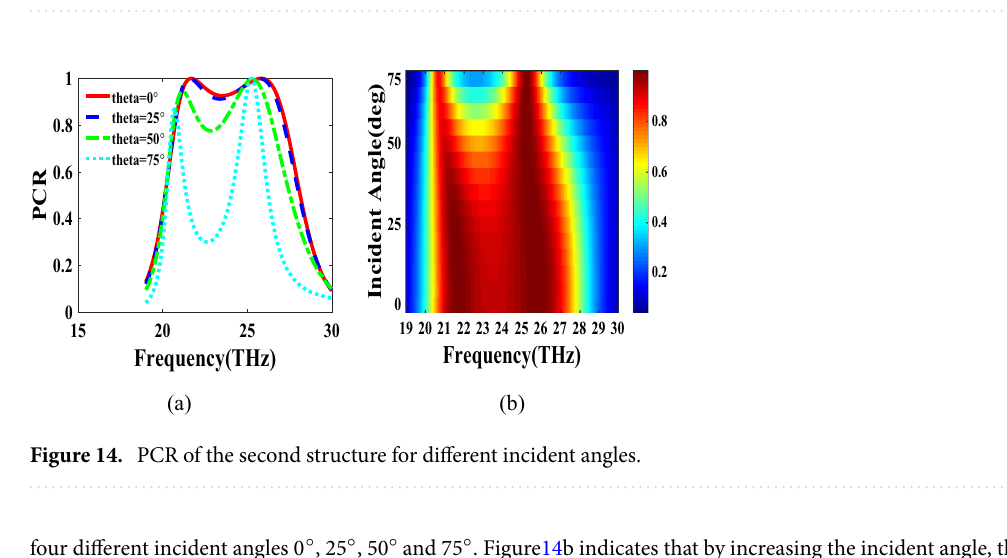
Figure 13. PCR of the second structure for different chemical potentials of graphene.